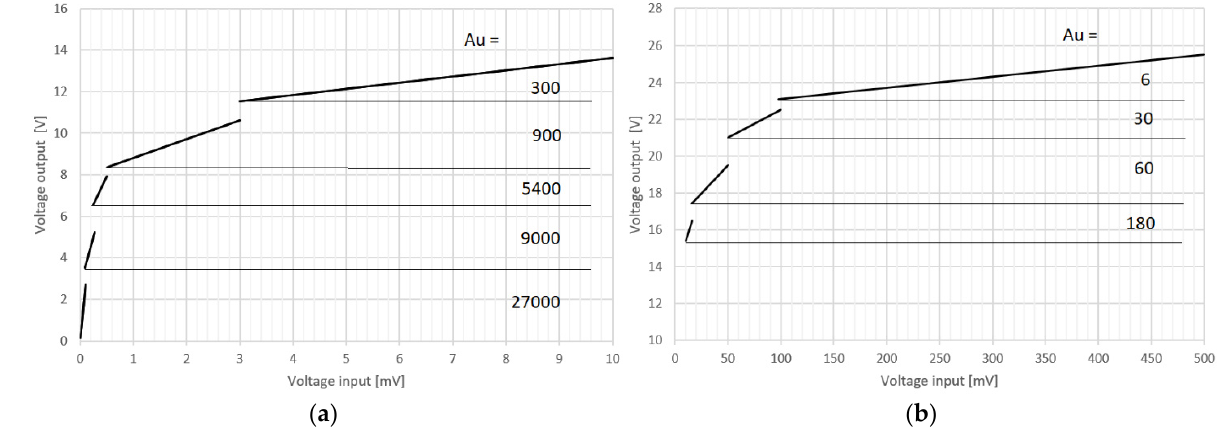
Figure 7. Output voltage as a function of system input voltage. ( a ) system dynamics for gains of 300 to 27,000; ( b ) system dynamics for gains of 6 to 180 V/V.